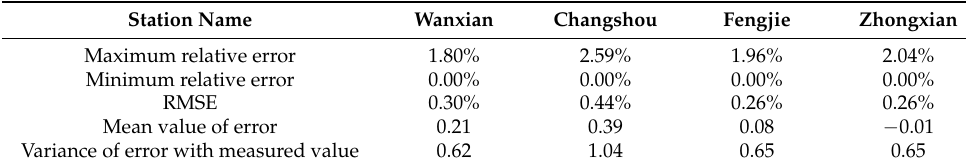
Table 3. Comparison of simulation and measured results for different hydrological stations during the validation